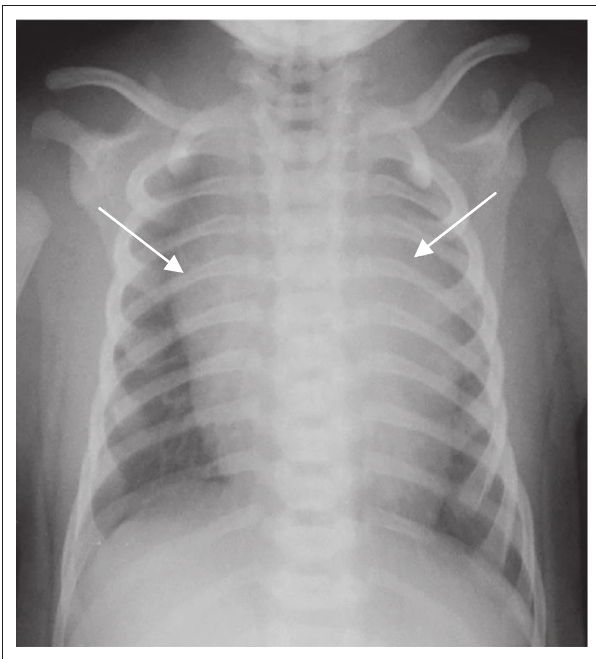
FIGURE 1: Frontal chest radiograph in an infant. A prominent thymus (arrows) gives an impression of a widened mediastinum.